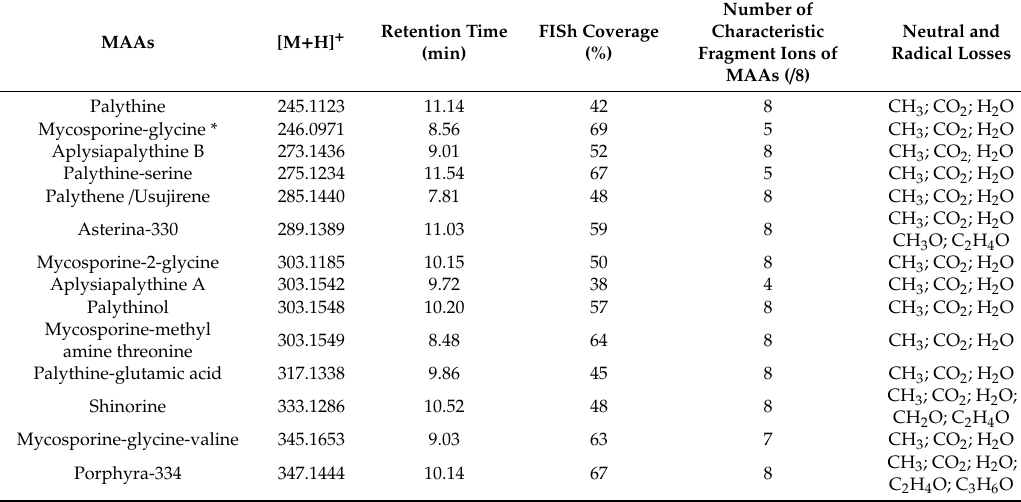
Table 4. Targeted analysis of the model algal sample Gymnogongrus devoniensis . FISh coverage indicates the percentage of experimental fragment ions matching with those obtained in silico